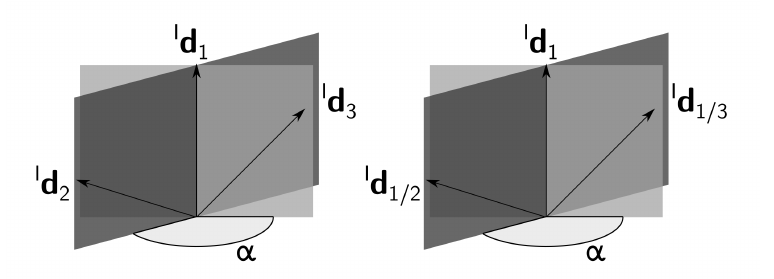
Figure 3. Geometric interpretation of the ambiguous configuration condition with